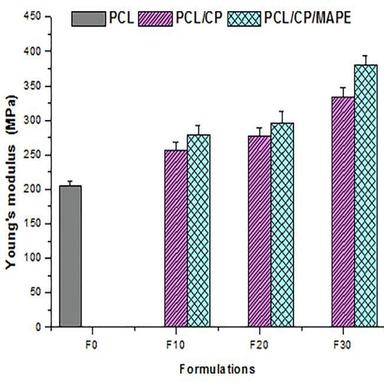
Evolution of the Young's modulus of composites PCL/CP with and without compatibilizer agent.